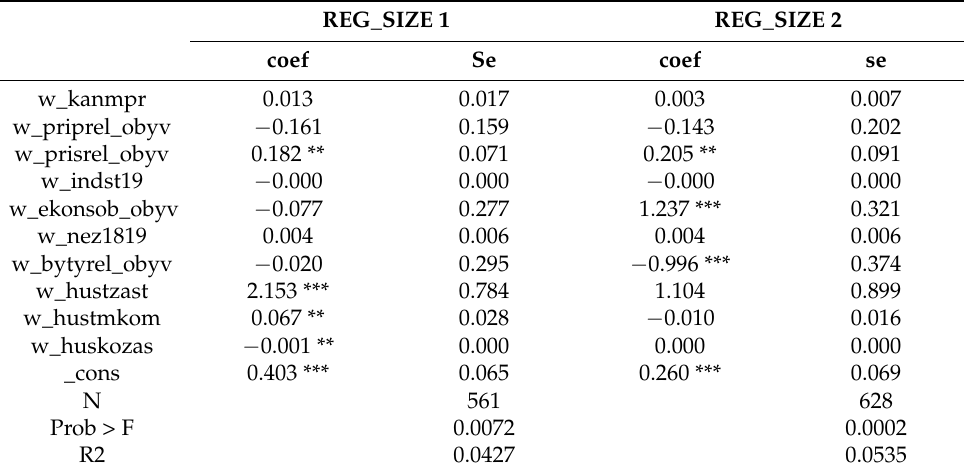
Table 5. Results of the estimate of multiple linear